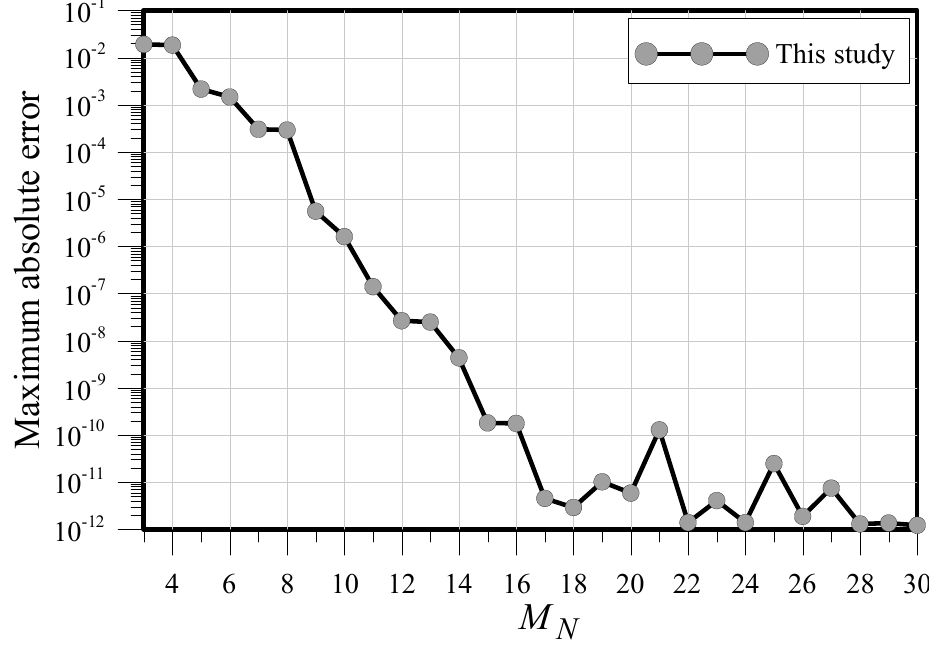
Figure 2. The number of terms of the radial polynomial basis function versus maximum absolute error.